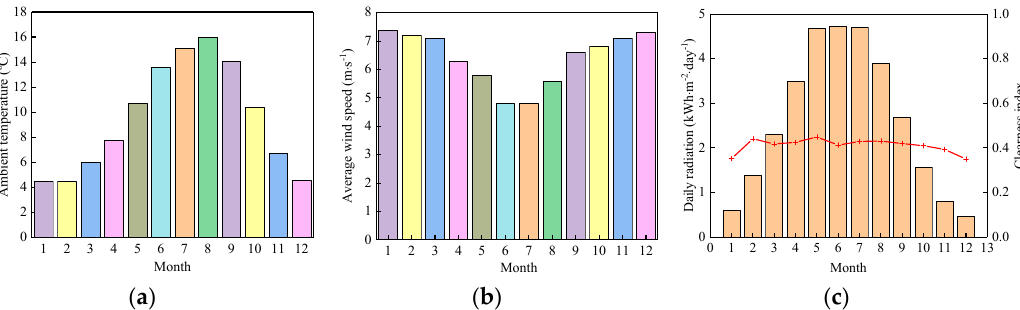
Figure 4. Monthly ( a ) ambient temperature, ( b ) wind speed and ( c ) solar radiation and clearness in Newcastle.